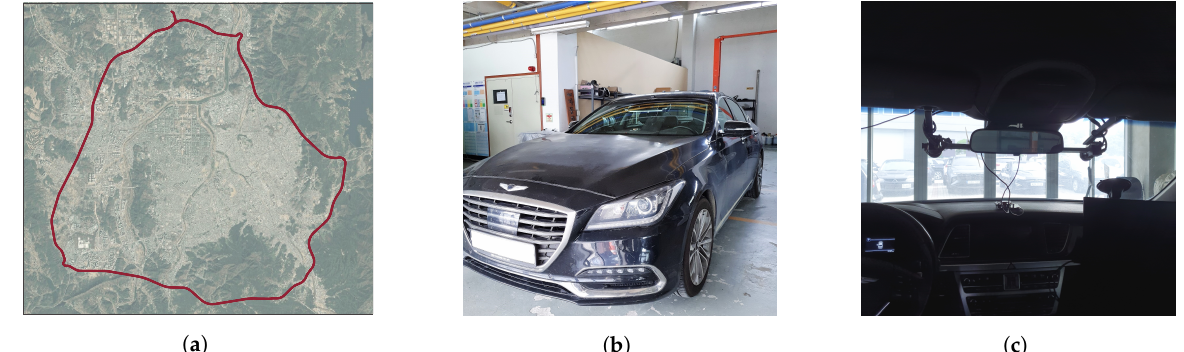
Figure 6. Test Environment and Experimental Setups are described in the figure. The experiment was done in Daejeon, South Korea, with a stereo camera-attached test vehicle (GENSIS G80 Sedan). ( a ) Experiment Trajectory, ( b ) GENESIS G80 Sedan ( c ) Stereo